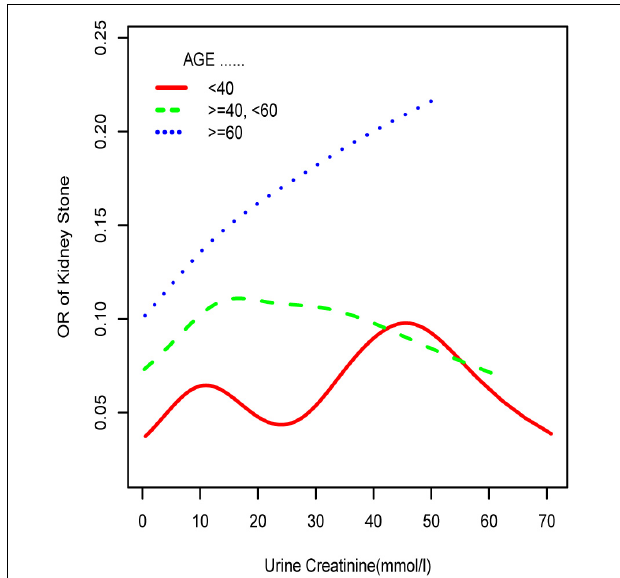
FIGURE 5 | Smooth curve fittings model in the subgroup analysis stratified by age. Sex, race, education, marital status, annual household income, diabetes, systolic blood pressure, diastolic blood pressure, BMI, glycosylated hemoglobin, blood urea nitrogen, total cholesterol, serum calcium, total triglyceride, total protein, serum glucose, serum uric acid, and serum creatinine were adjusted.